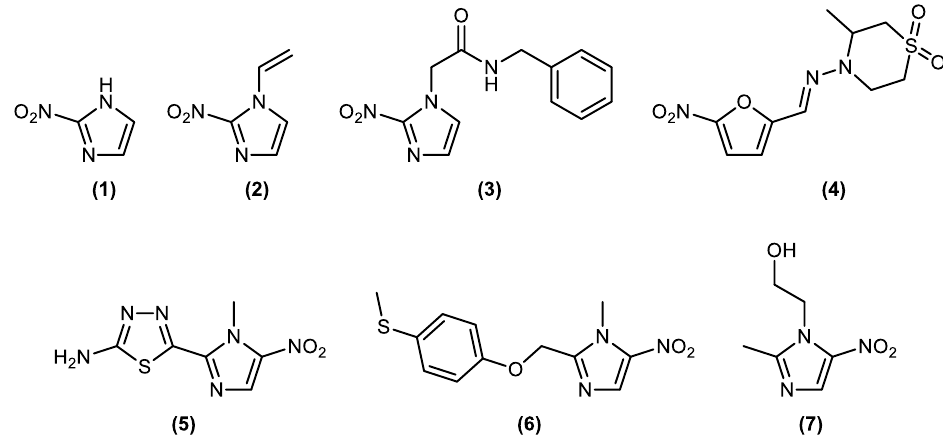
Figure 1. Drugs and other bioactive molecules containing the nitroimidazole core.